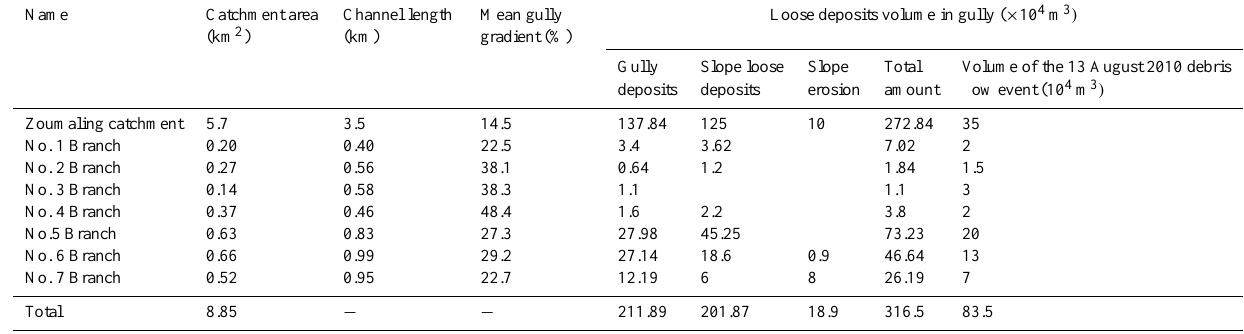
Table 3. Basic data for 7 tributary-gullies and the main-gully in the Zoumaling catchment.